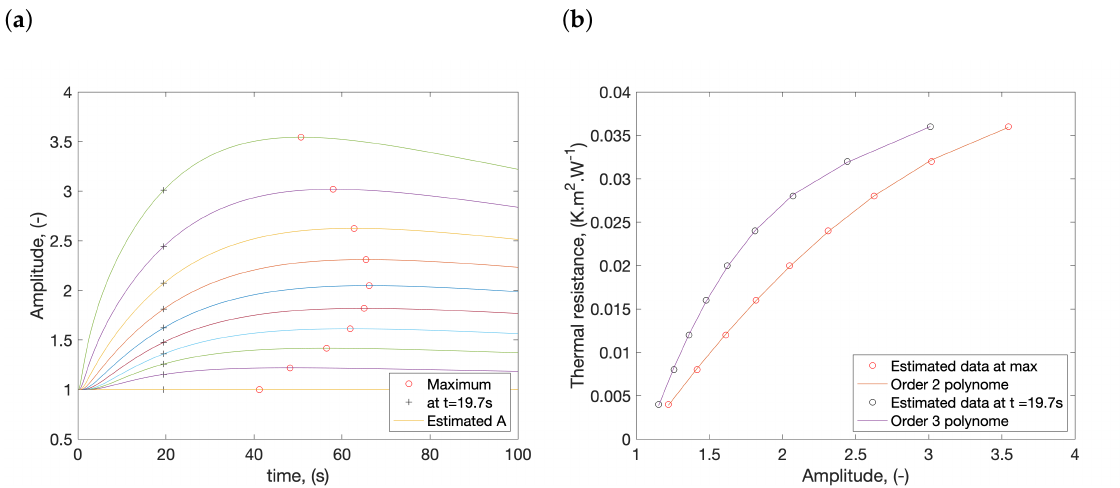
Figure 5. Results of the autoregressive inverse method based on the simulated analytical temperature response from Figure 4: ( a ) estimated amplitude A as a function of time, the solid lines corresponds to the different Rth of the Figure 4 and ( b ), calibration curve obtained from the extraction of the maximum amplitude A as a function of the thermal resistance and amplitude at any time step of 19.7